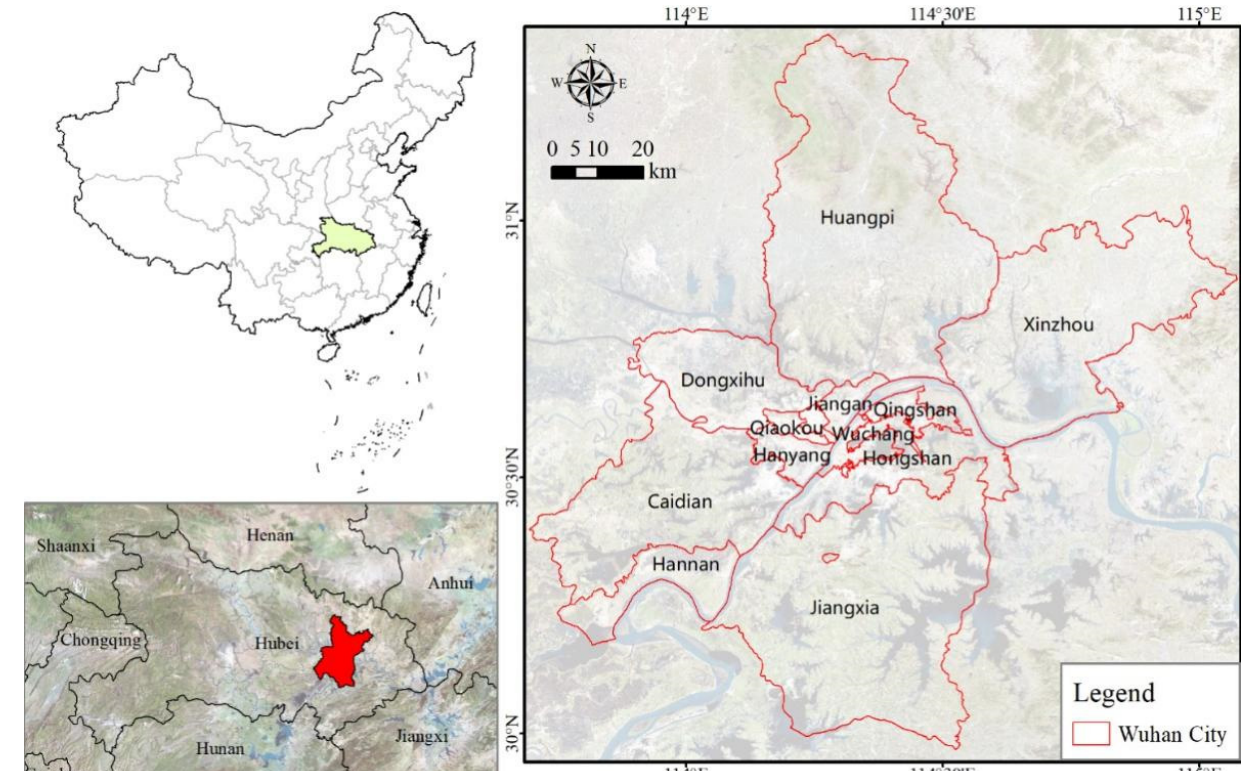
Figure 1. The geographical location of Wuhan city, China.